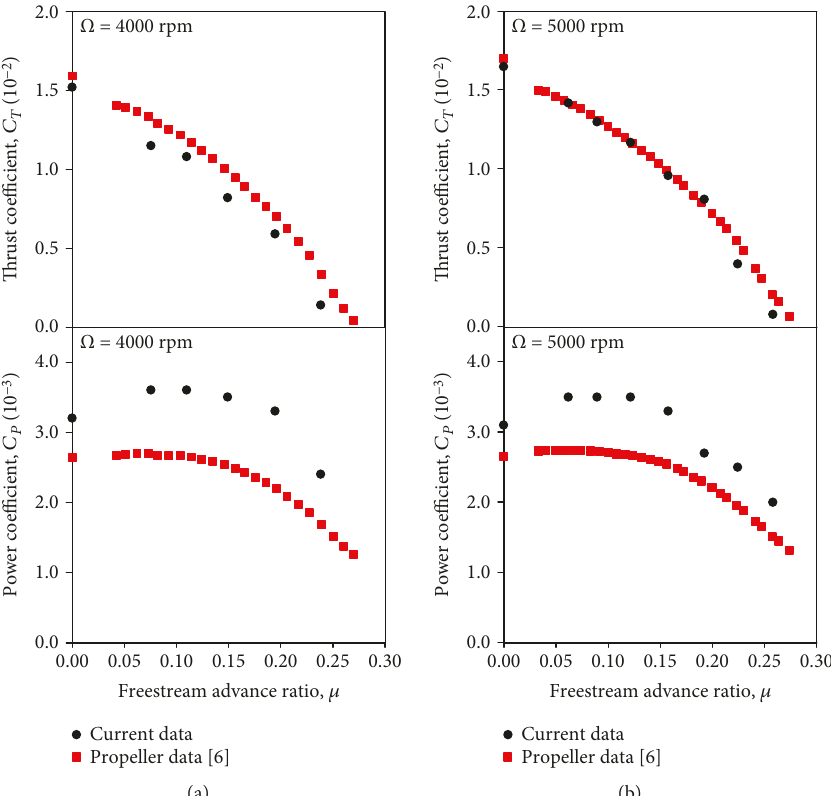
Figure 7: Comparison of thrust and power coe ffi cients for MAE 11x7 at 90 ° angle of attack: (a) Ω =4000 rpm; (b) Ω =5000 rpm. 0.00.51.01.52.0